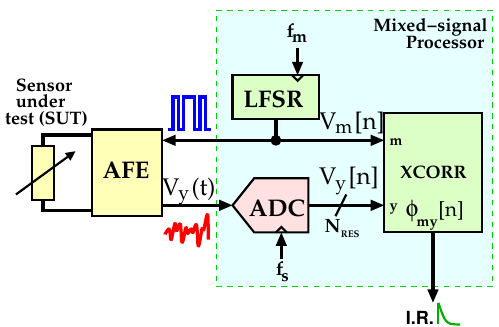
Figure 1. Conventional architecture for MLS-based EIS of